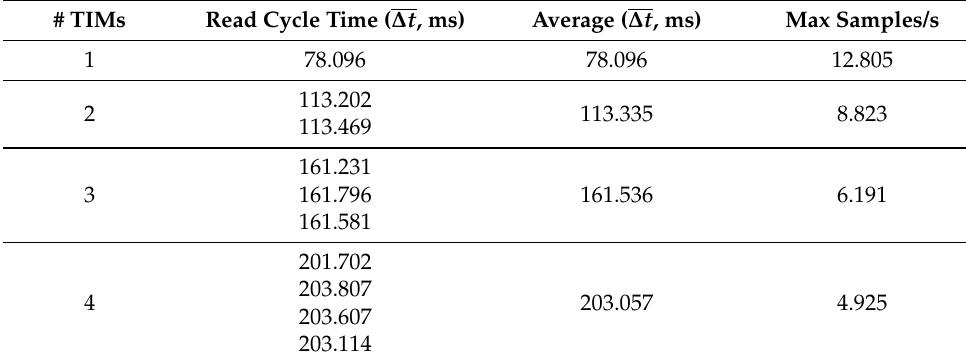
Table 4. Read Sensor Tests—Read Cycle Times, direct access to TS. # TIMs Read Cycle Time ( ∆ t ,